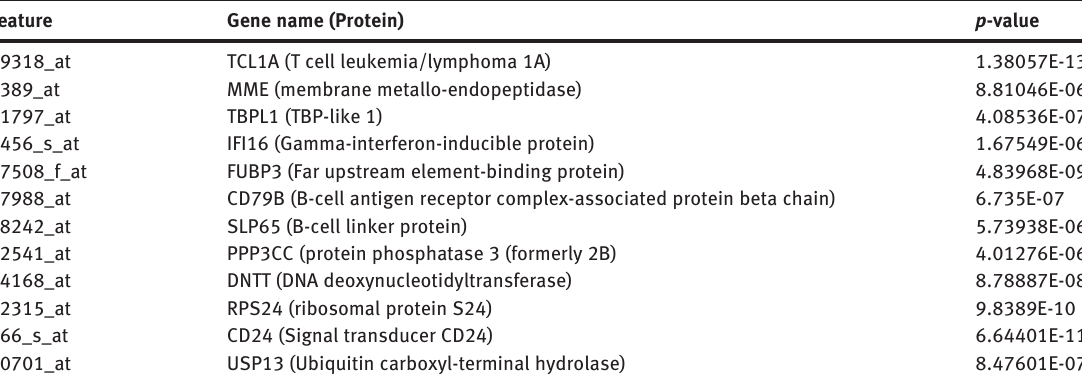
Table  : Features with highest average merit of information gain attribute selection after used metalearner correlation-KLR with  -fold cross-validation.